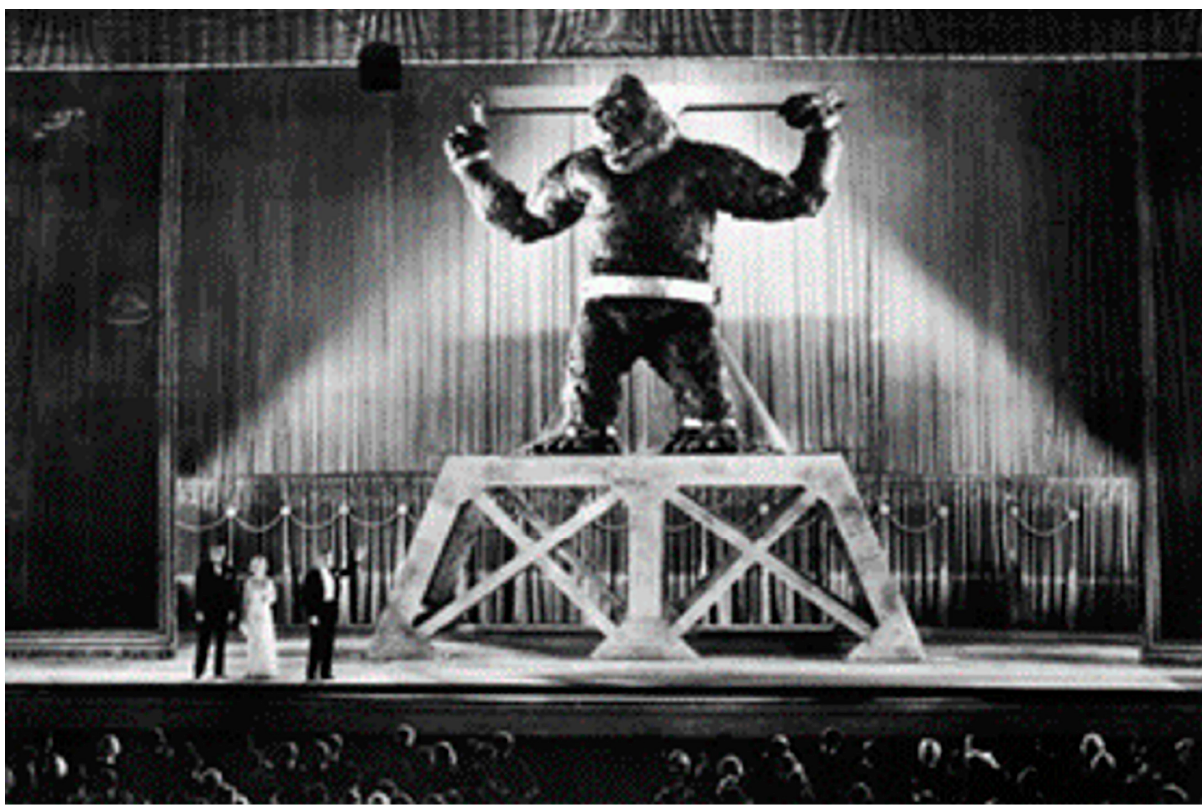
Figure 20. King Kong is crucified (1933). https://www.tíritumind.com/check-onscreen-evolution-king-kong/ (accessed on 1 January